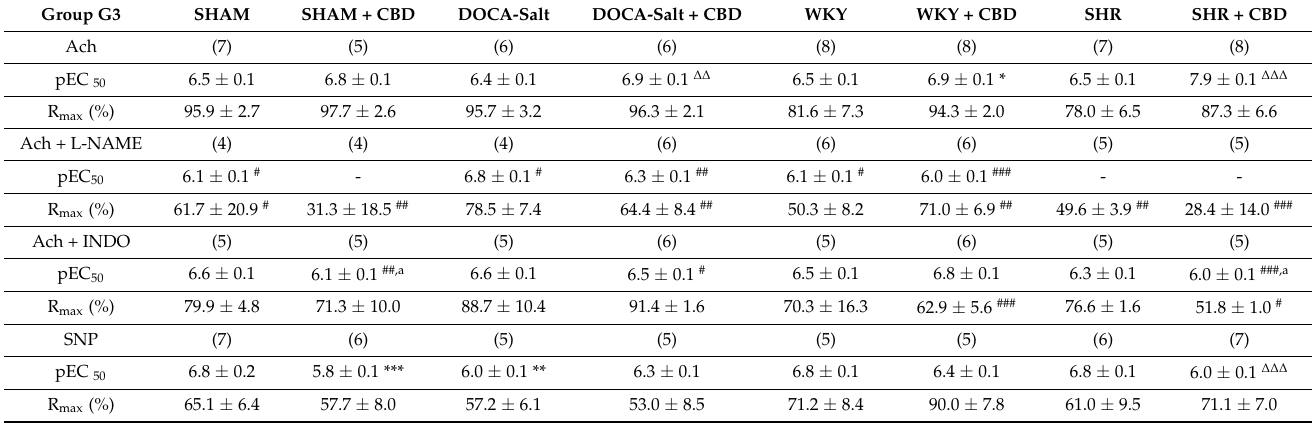
Table 2. The influence of cannabidiol (CBD) and its vehicle on the vasorelaxant effects of acetylcholine (Ach), also in the presence of L-NAME (300 µ M) and indomethacin (INDO, 10 µ M), and sodium nitroprusside (SNP) in the endothelium-intact small mesenteric (G3) arteries isolated from deoxycorticosterone-salt (DOCA-salt) and spontaneously (SHR) hypertensive rats and their respective normotensive controls, sham-operated (SHAM) and Wistar-Kyoto (WKY) rats, respectively. Group G3